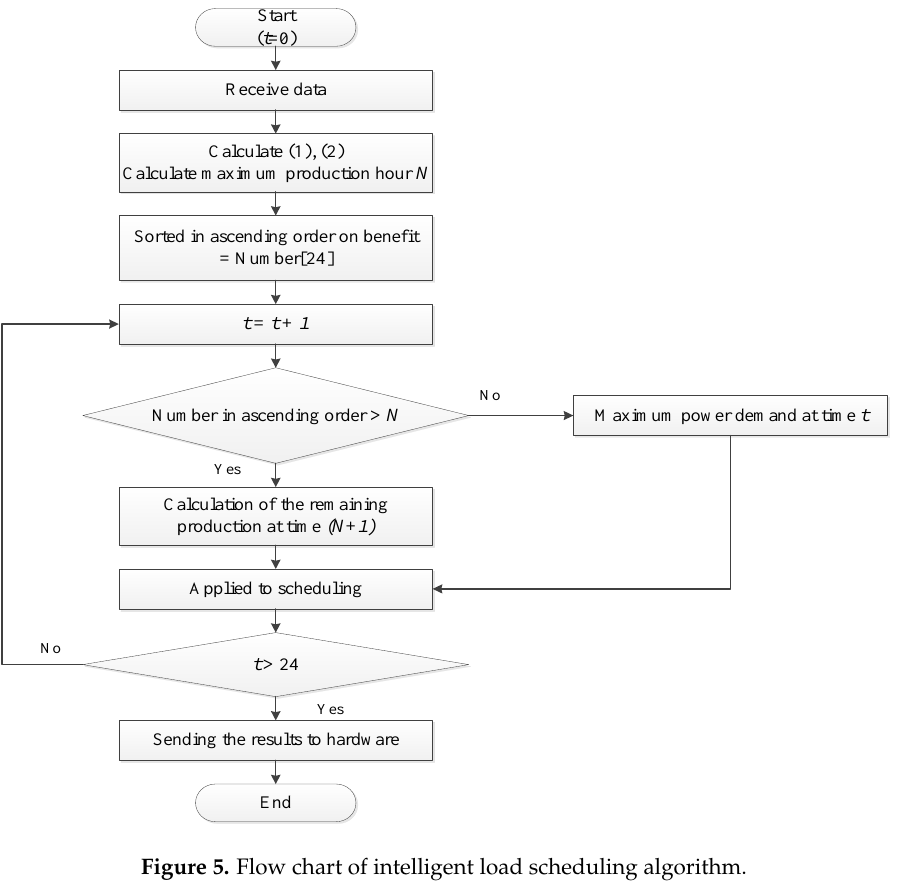
Figure 5. Flow chart of intelligent load scheduling algorithm.